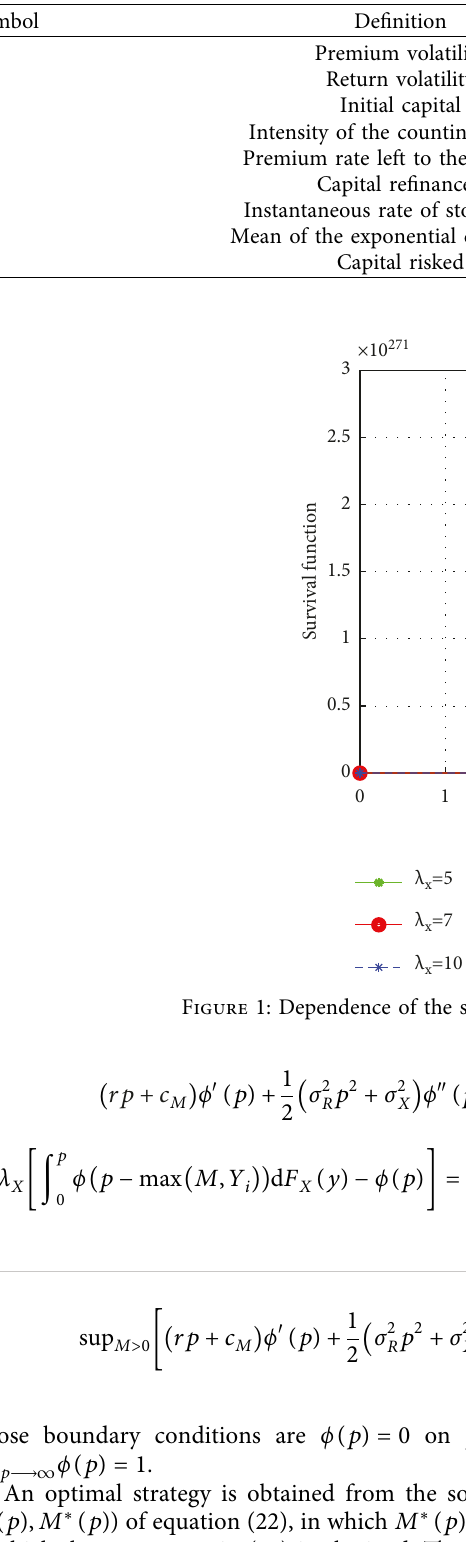
Table 1: Model parameters and their values.